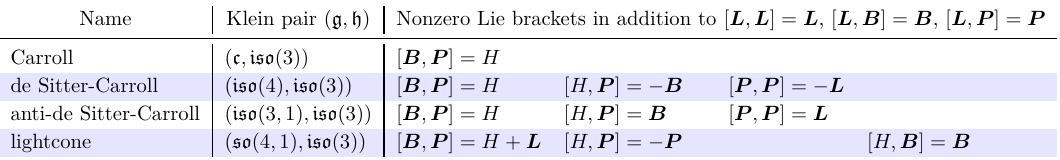
Table 3 . Spatially isotropic homogeneous carrollian four-dimensional spacetimes. The Lie algebra g is different in each case and spanned by rotations L , (carrollian) boosts B , temporal translations H and spatial translations P . In all cases the Lie subalgebra of the Klein pair h ∼ = iso (3) is spanned L and B